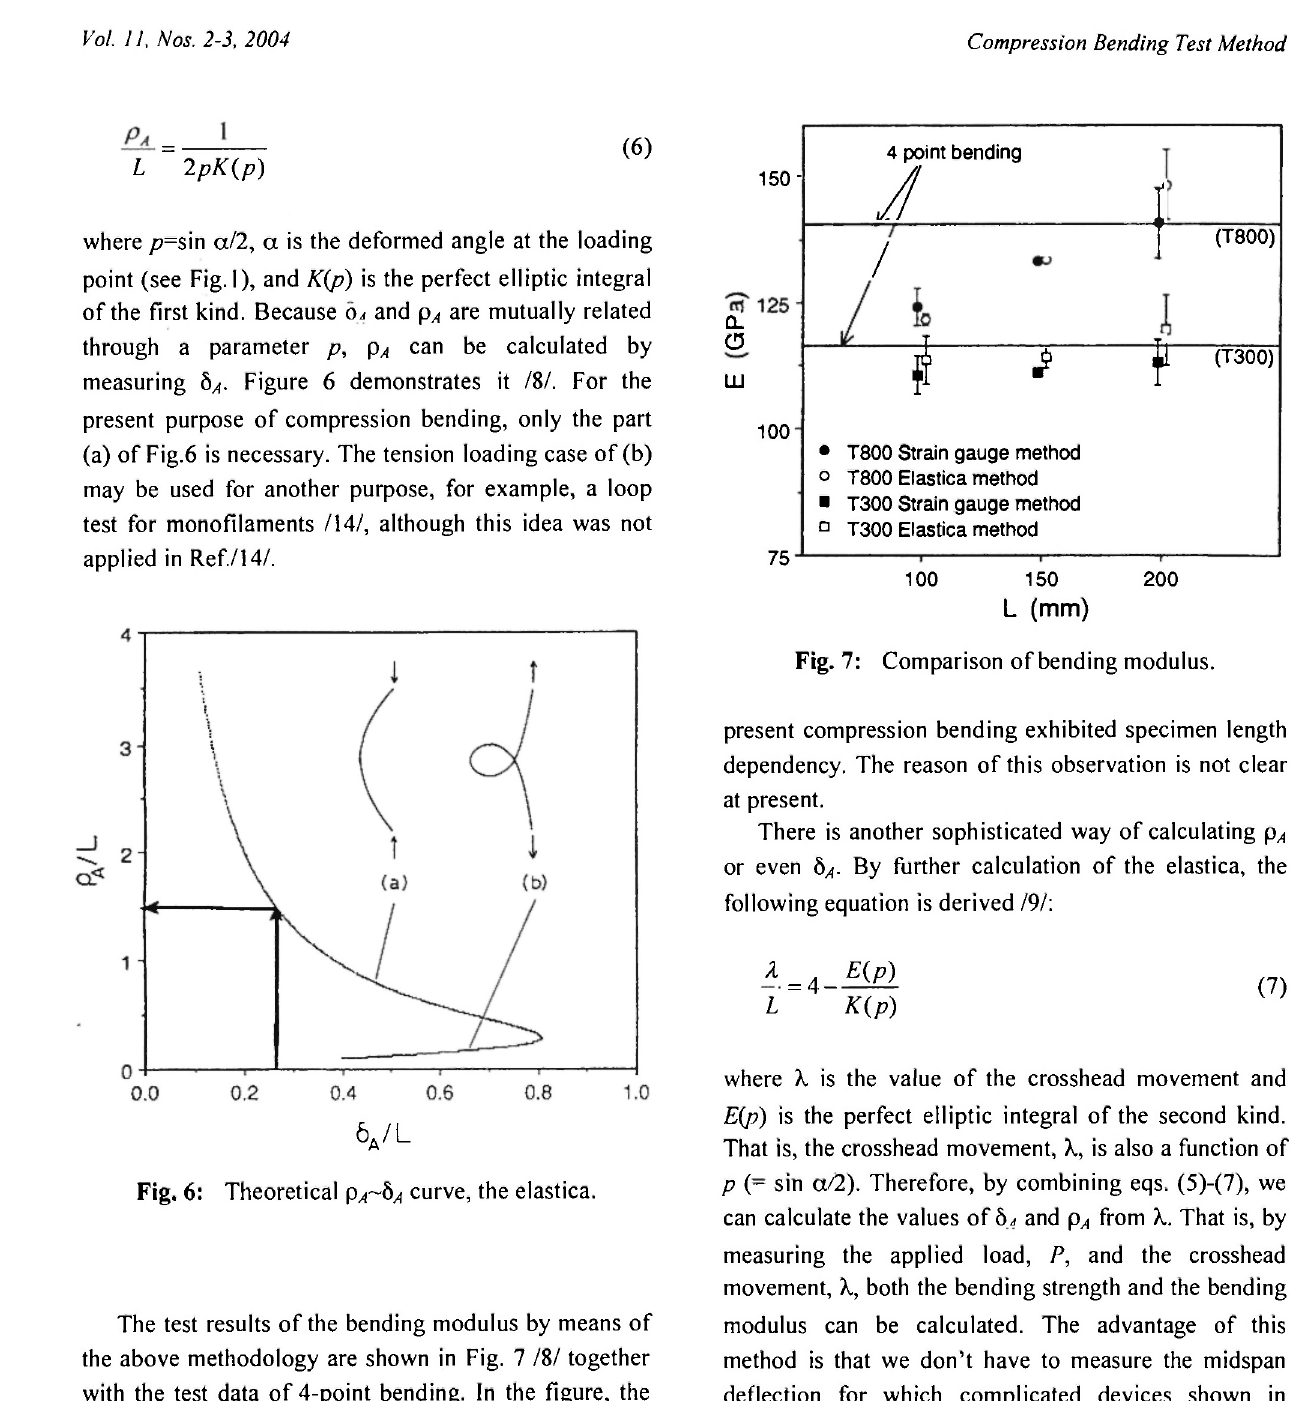
Fig. 6: Theoretical ρ^-δ^ curve, the elastica.